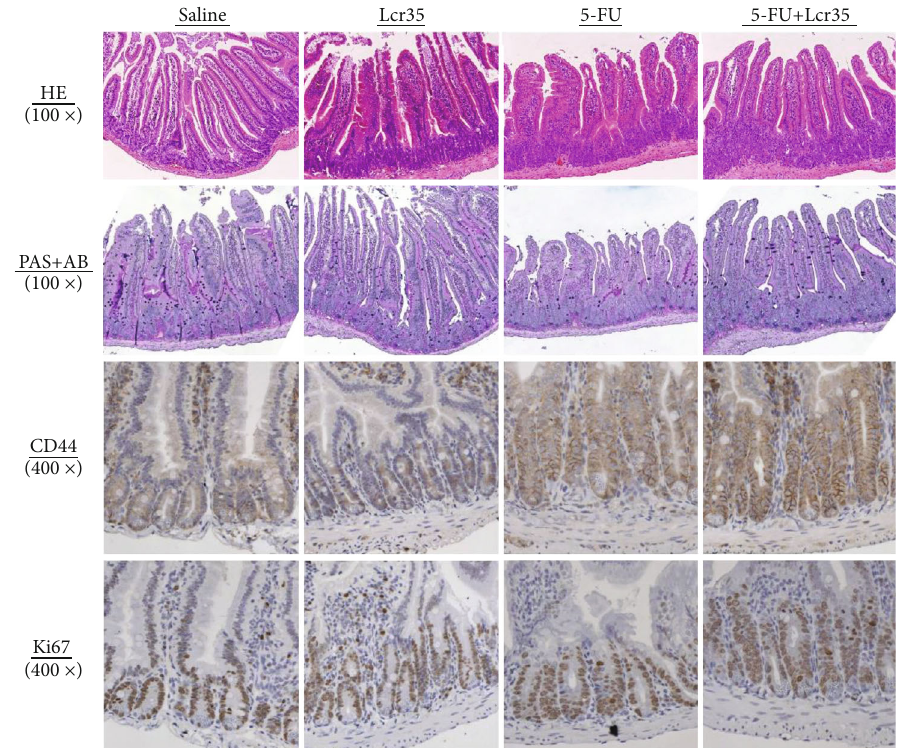
Figure 6: Representative histology of the jejunum showing villus height and crypt depth with hematoxylin and eosin stain. Microscopical fi ndings of the intestinal mucosa from mice exposed to 5-FU-induced mucositis at the jejunum. Goblet cells were found in PAS+AB- stained sections. Intestinal stem cells CD44 markers and proliferation of crypt (Ki67 expression) were shown by IHC methods. CD44 analysis of intestinal stem cells and Ki67 immunolabeling of the jejunum from mice were assessed after 5-FU treatment. 5-FU signi fi cantly decreased villus height compared to the saline controls, and the e ff ect was restored by probiotic treatment. 5-FU signi fi cantly lengthened the crypt depth of the intestine compared with the saline controls, and the e ff ect was signi fi cantly restored by probiotic treatment. Table 1: Translocation of probiotics to the mesenteric lymph node, spleen, liver, and blood in 5-FU-treated mice fed with or without Lcr35. Cultured bacteria were from plate colonies and identi fi ed by the genomic sequence. a E. coli str. K-12; E. coli O157:H7 str. Sakai ; and E. coli UMN026 were identi fi ed. b Enterococcus dispar ATCC 51266 genomic sca ff old; Enterococcus faecalis ; and Enterococcus casseli fl avus EC20 were identi fi ed.